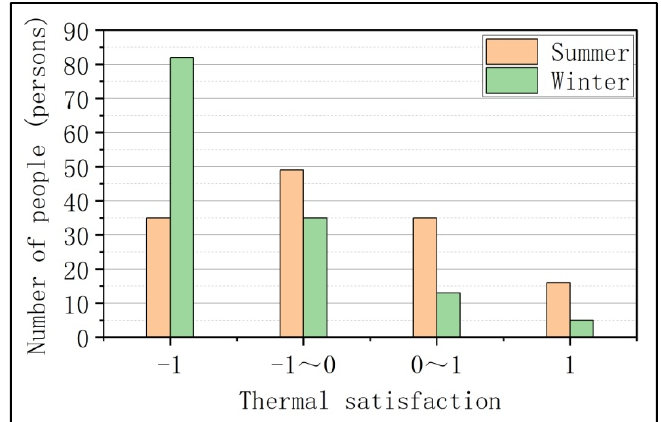
Figure 23. Satisfaction degree of the indoor thermal environment.